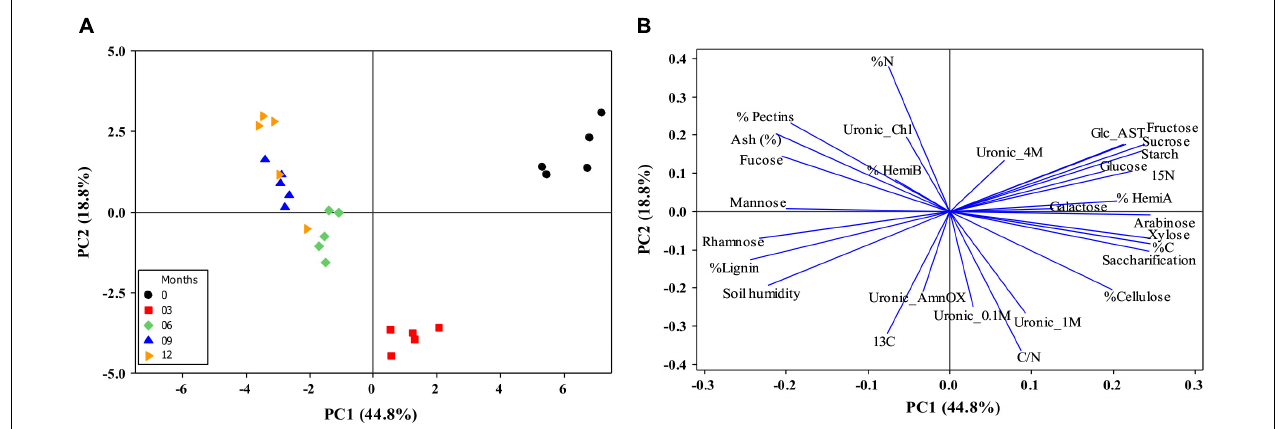
FIGURE 10 | Distance biplots from straw on the field during 0 to 12 months. (A) The centroids separation corresponds to the straw harvest distribution for months harvests in the plane defined by the first and second main components (PC1 and PC2). Percentage values in parentheses ( x and y axes) show the proportion of the variance explained by each axis. (B) Plot of the PC1 and PC2 loading vectors, describing the relationship among variables of straw composition during the harvests. The variables analyzed were expressed in descriptor vectors: Lignin, saccharification, ash, percentage and monosaccharide composition of cell walls (glucose, fucose, galactose, arabinose, xylose, rhamnose, and mannose), non-structural carbohydrates (glucose, fructose, sucrose, and starch), soil humidity, Uronic Acid, Carbon and Nitrogen (C and N), C/N ratio,15N, and 13C ( n =